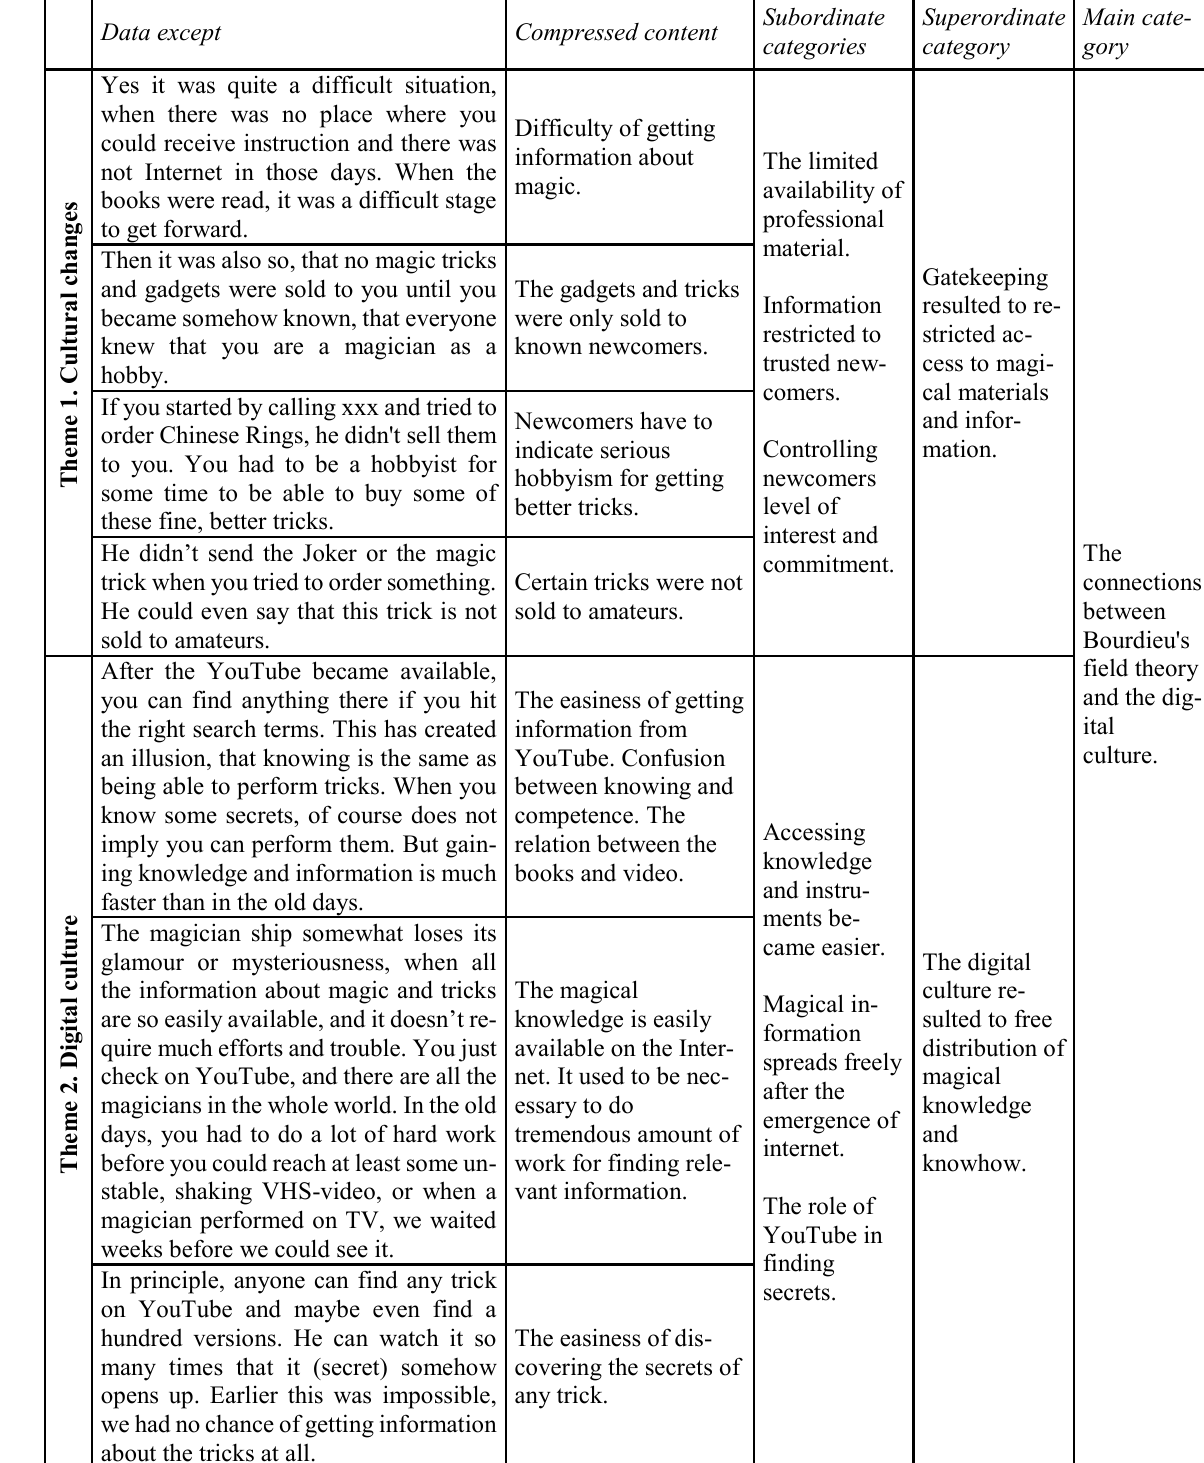
Table 1. An example of categorizing gatekeeping related